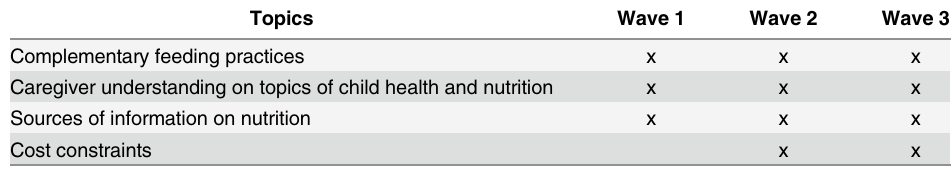
Table 3. Topics of Questions asked in each phase of